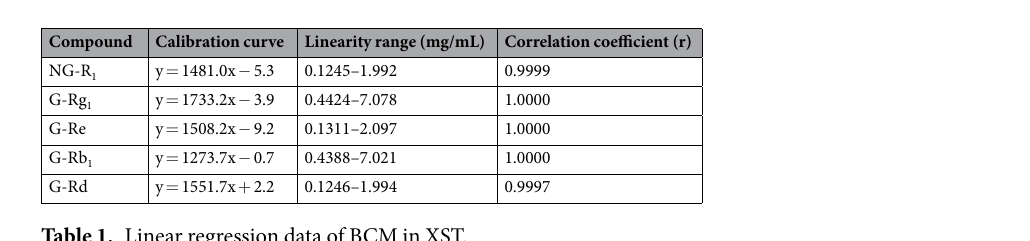
Table 1. Linear regression data of BCM in